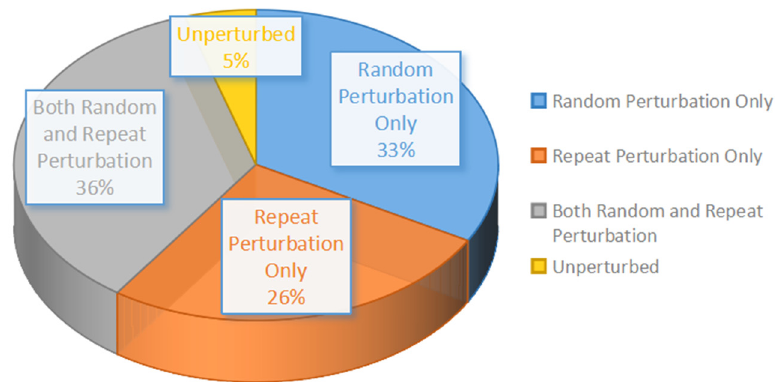
Figure 3. A Pie chart showing the distribution of cortical encoding .